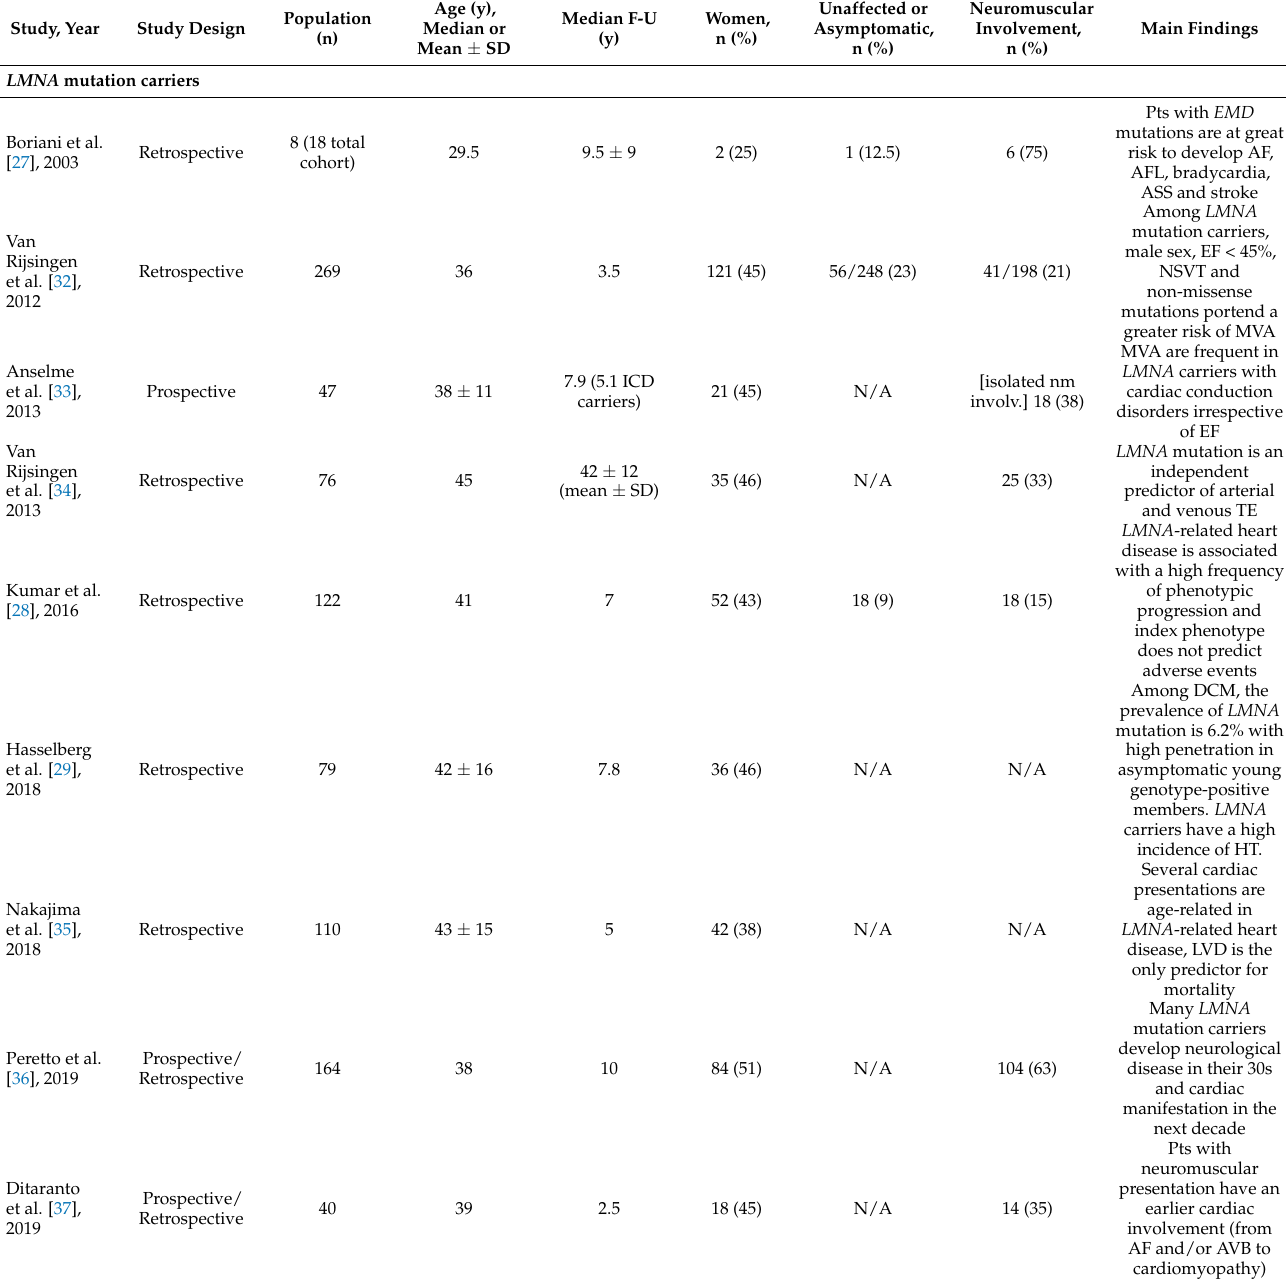
Table 1. Study design and baseline